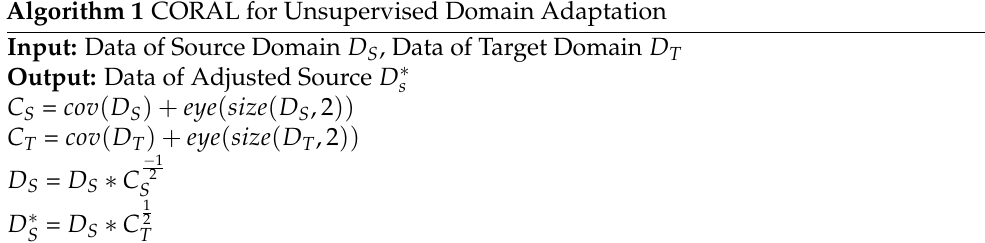
Algorithm 1 CORAL for Unsupervised Domain Adaptation